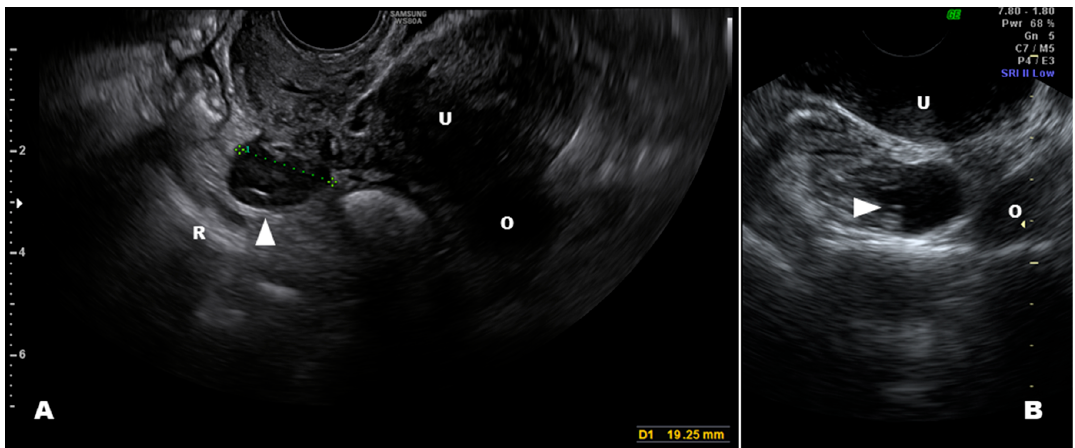
Figure 3. Cystic endometriosis (arrow) of the retroperitoneum in two patients on medical therapy with previous pelvic surgery for endometriosis. ( A ) shows an endometriosis cyst of the rectovaginal septum and ( B ) shows a cyst of the mesometrium. Abbreviations: U, uterus; R, rectum; O, Ovary.